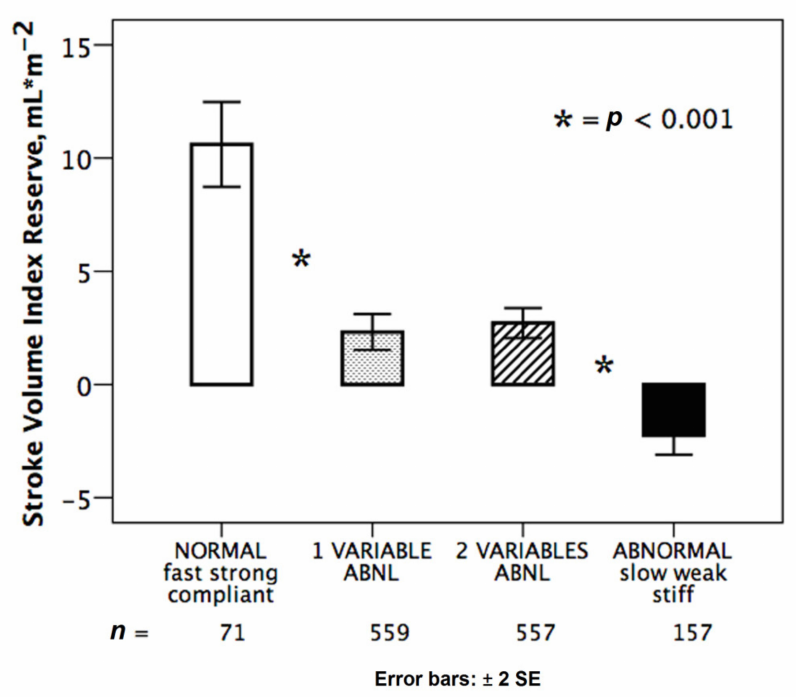
Figure 2. Normal and abnormal hemodynamic responses during stress. Stroke volume index reserve in normal response (white bar): abnormal responses (black bar) with reduced chronotropic, preload and contractile reserve; partially abnormal responses with one (dotted bar: stiff, n = 322; weak, n = 170; slow, n = 66) or two abnormalities (dashed bar: weak + slow, n = 229; stiff + slow, n = 178; stiff + weak, n = 151). * = p < 0.001 across various subsets.